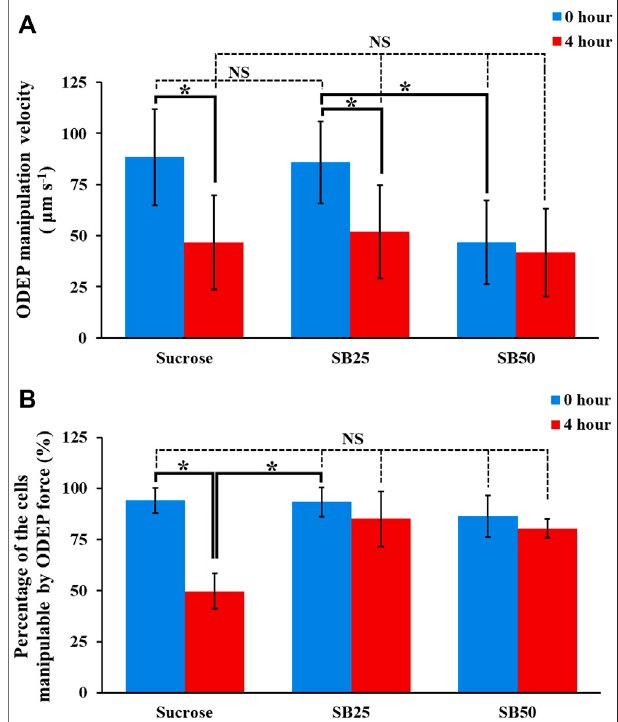
FIGURE 6 | The (A) ODEP manipulation velocity and (B) percentage of the cells manipulatable by the ODEP force of the PC-3 cancer cells incubated in sucrose solution (9.5%), and sucrose solutions supplemented with BSA (SB25 and SB50; Table 1 ) for 0 and 4 h, respectively. The results are presented as the mean ± standard deviation of at least 3 separate experiments. [NS, no signi fi cance and *, signi fi cant difference ( p <